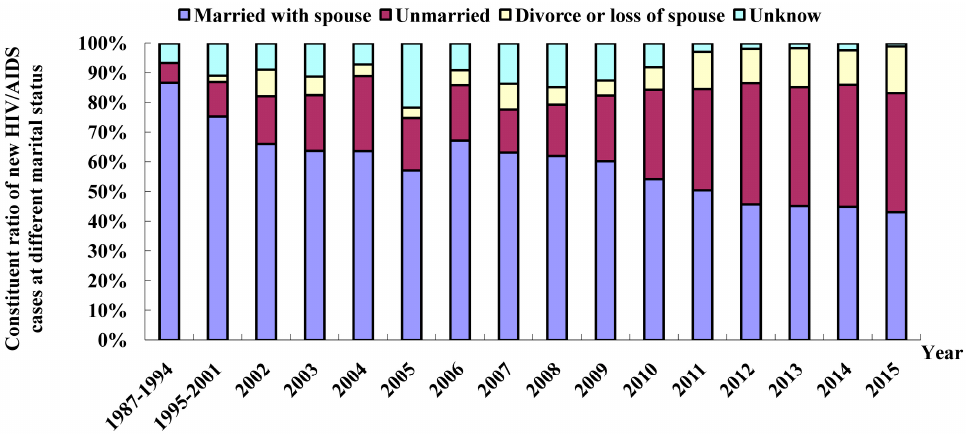
Figure 4. Distribution of new HIV/AIDS patients by marital status in Fujian Province from 1987 to 2015.